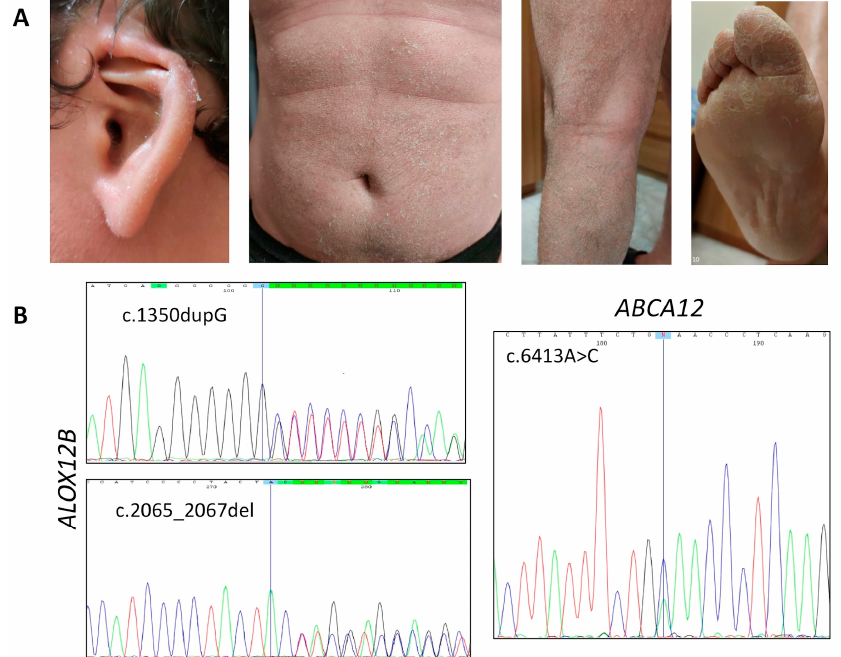
Figure 1. Phenotypic and genetic features of patient 1. ( A ) Overfolded ear, patchy erythema associated with white scales, which are largest and grey on the legs, and plantar hyperkeratosis. ( B ) Sanger sequencing electropherograms showing the ALOX12B small deletions at the heterozygous state ( left ), and the heterozygous ABCA12 nucleotide change leading to the missense variant p.Glu2138Ala ( right ).